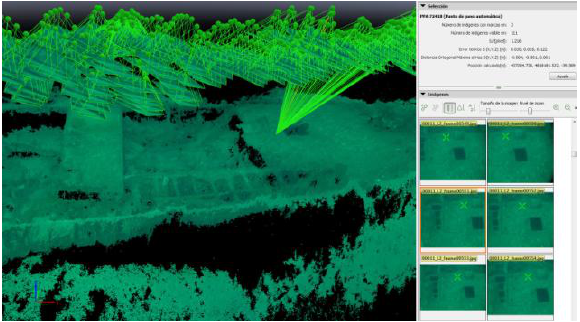
Figure 3: 3D reconstruction of video transect in Pix4D Mapper Pro software - Green points are camera position